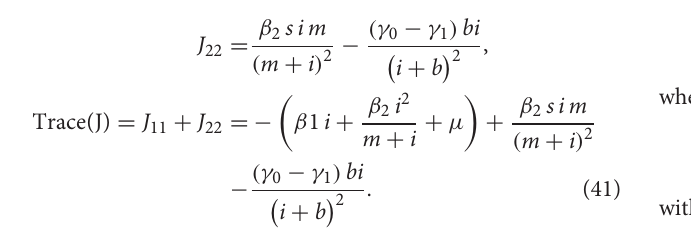
TABLE 2 | Model parameters.